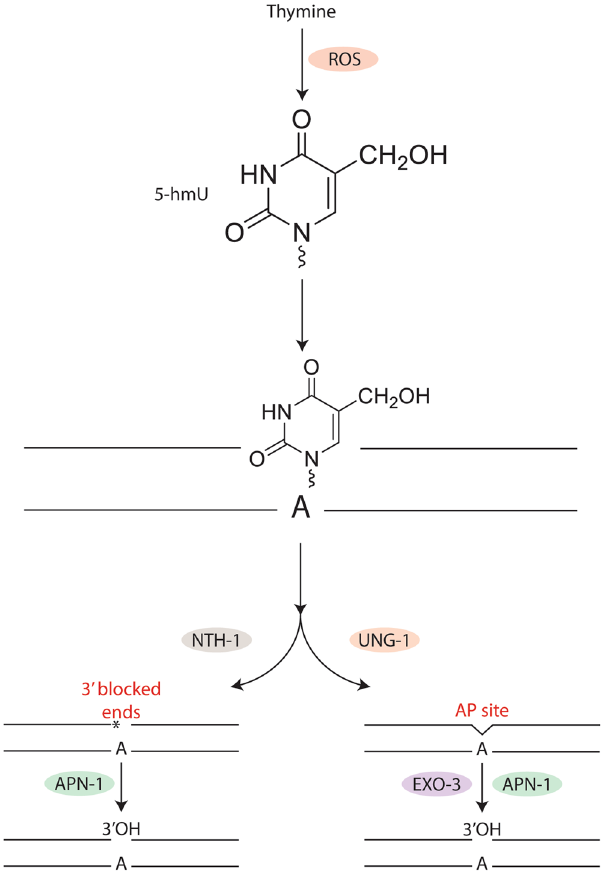
Figure 8. A model illustrating the repair of 5-hmU opposite adenine (5-hmU • A) via the BER pathway. Under physiological conditions thymine in the genome is oxidized to 5-hmU creating the mispair 5-hmU • A. In this model, UNG-1 is proposed to recognize and remove 5-hmU creating an AP site that can be processed by either APN-1 or EXO-3. In the absence of UNG-1, NTH-1 removes the 5-hmU lesion and simultaneously cleaves the resulting AP site to create a secondary 3 ′ -blocked genotoxic lesion, 3 ′ - α , β unsaturated aldehyde, which requires processing by the 3 ′ -diesterase or 3 ′ - to 5 ′ -exonuclease activity of APN-1. The 5-hydroxymethyluracil (5-hmU) structure was obtained from PubChem (ID: 78168) and rendered with